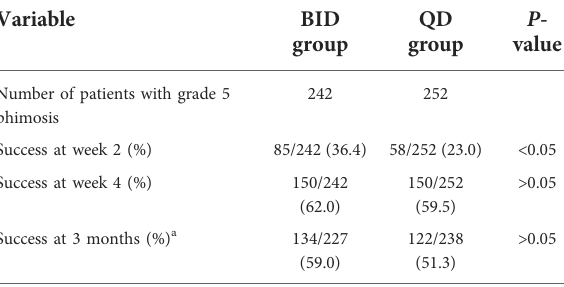
TABLE 3 Comparison in success outcomes of patients with grade 5 phimosis between the BID group and QD group. Variable